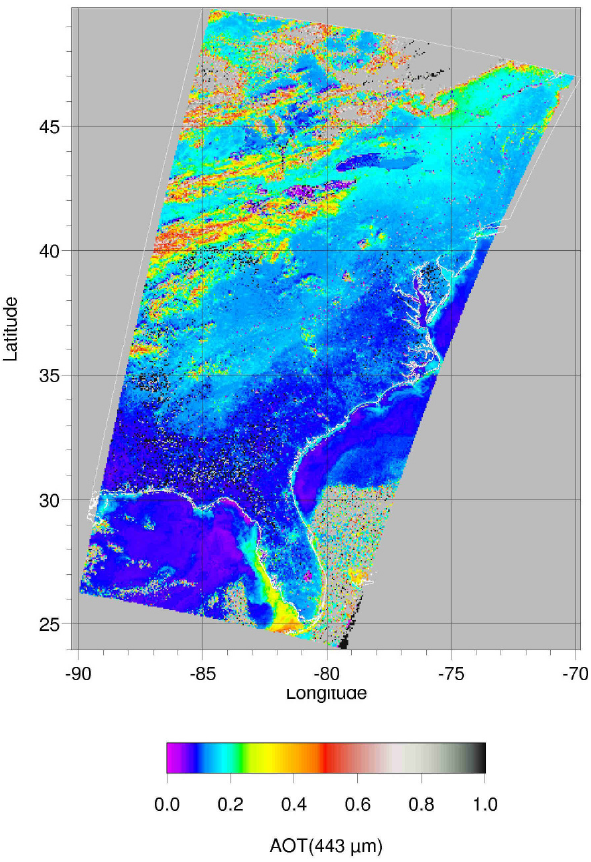
Fig. 11. Retrieval of AOT at 0.443µm for a clear day over eastern US on 21 November 2003, 15:48UTC. Aerosol source regions can be identified. New York, Philadelphia, Washington and some other urban areas in Florida can be identified with an increased AOT of about 0 . 07 to 0 . 1 compared to the surrounding conditions. Near the South-East coast of Florida disturbances from “case 2” – water with sediment content can be seen as apparently increased AOT.